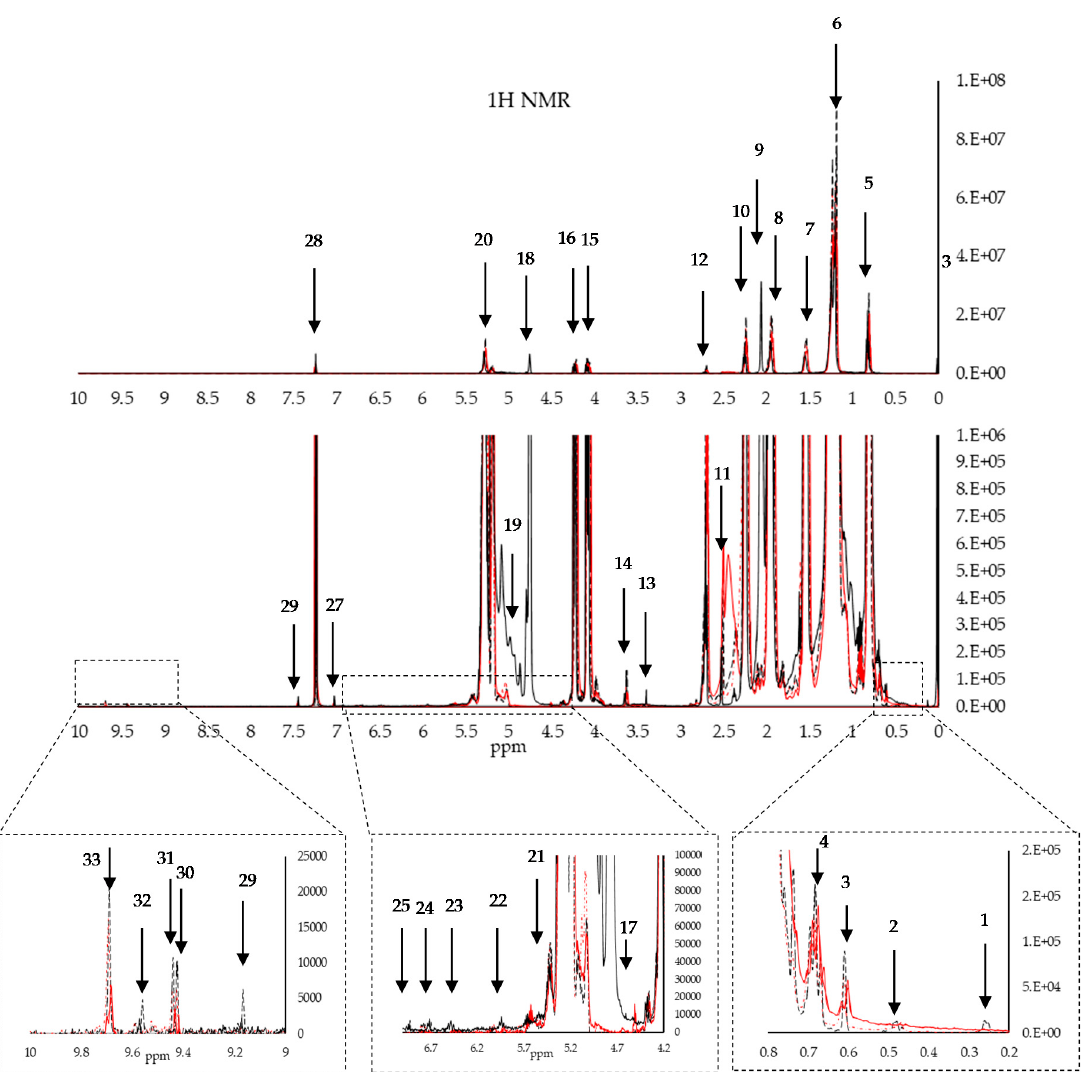
Figure 1. The major peaks of interest obtained from the nuclear magnetic resonance (NMR) of extra virgin olive oils (EVOOs) using the zg30 pulse sequence (black) and NOESY pulse sequence (red).